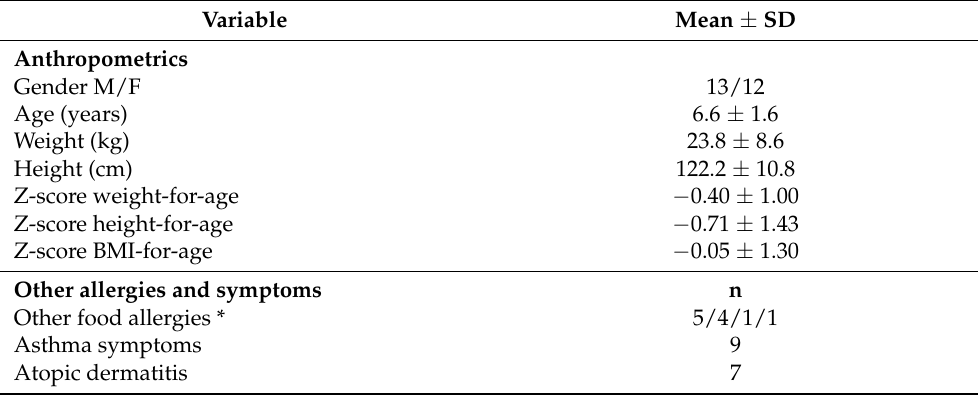
Table 1. Clinical phenotypic characteristics of children with cow’s milk allergy (n = 30).